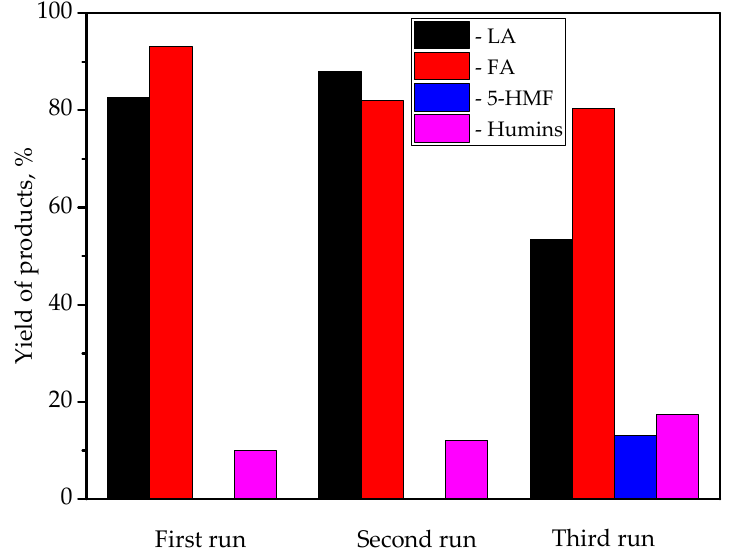
Figure 7. Recycling study of the ZrO 2 –SiO 2 –SnO 2 catalyst in the conversion of fructose to LA and FA. Reaction conditions: fructose (2 g, 11.1 mmol, 20 wt.%), H 2 O (10 mL), ZrO 2 –SiO 2 –SnO 2 catalyst (0.1 g) at 180 °C for 3.5 h.